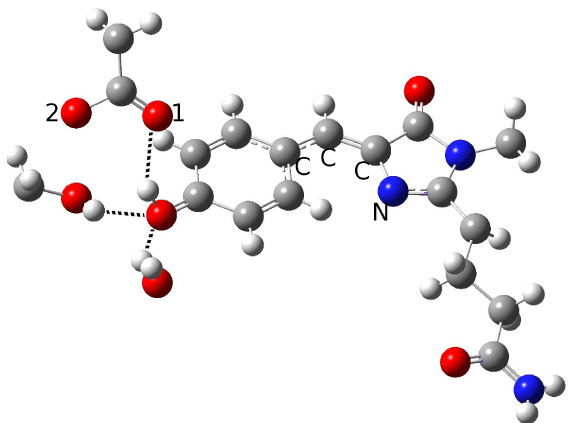
Figure 4. First hypothesized hydrogen bond network in neutral psamFP488 leading to ESPT on the basis of the experimental